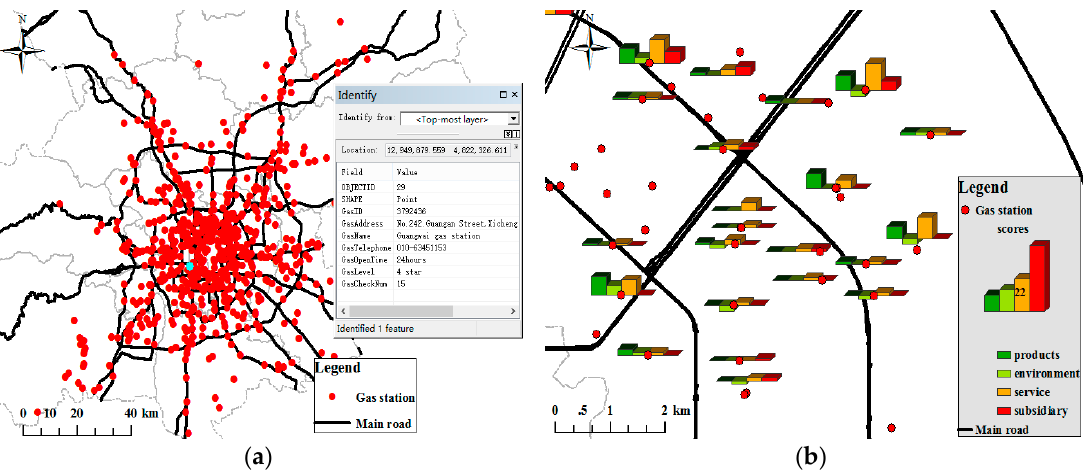
Figure 10. The results of the attribute and sentiment semantic information extraction from Dianping. ( a ) Gas station point of interest (POI) and attribute information extracted from Dianping; ( b ) Dimension sentiment scores visualization using Bar graph (part).